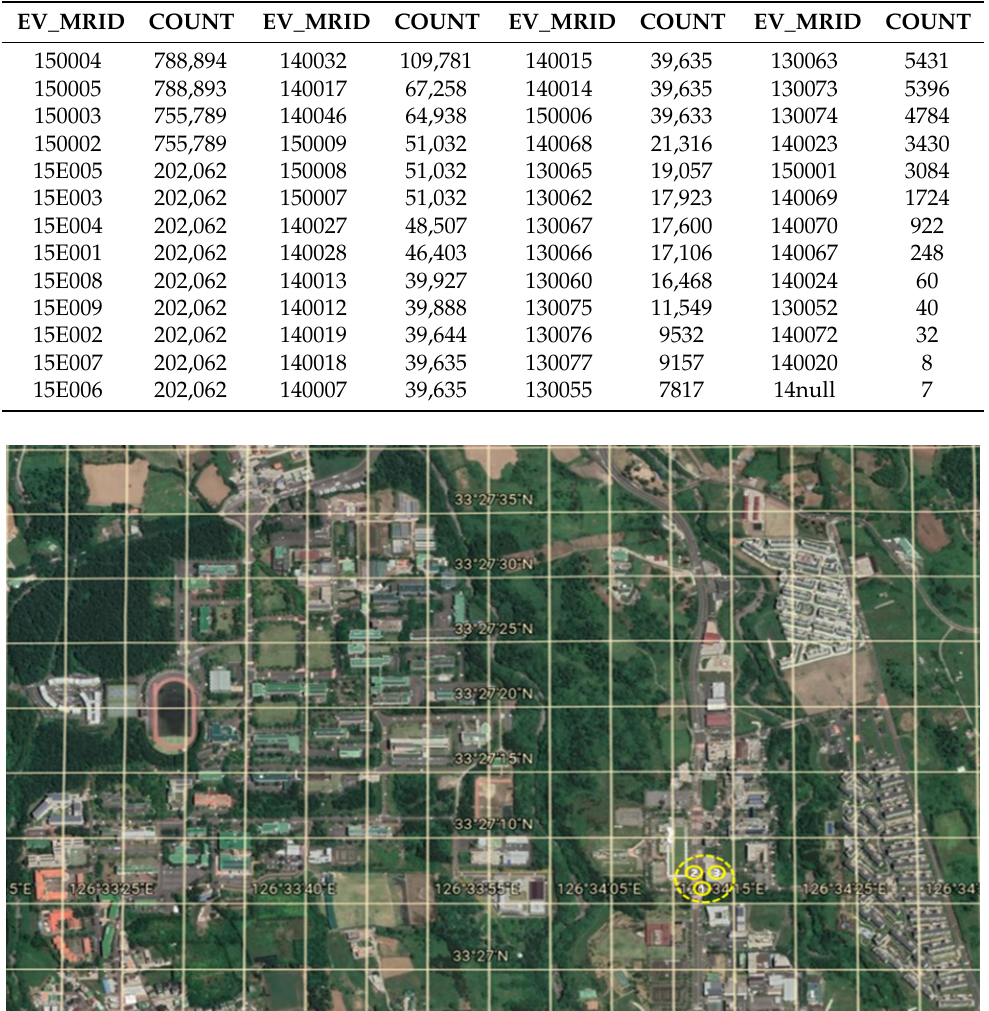
Figure 2. Criteria for EVGPS error range